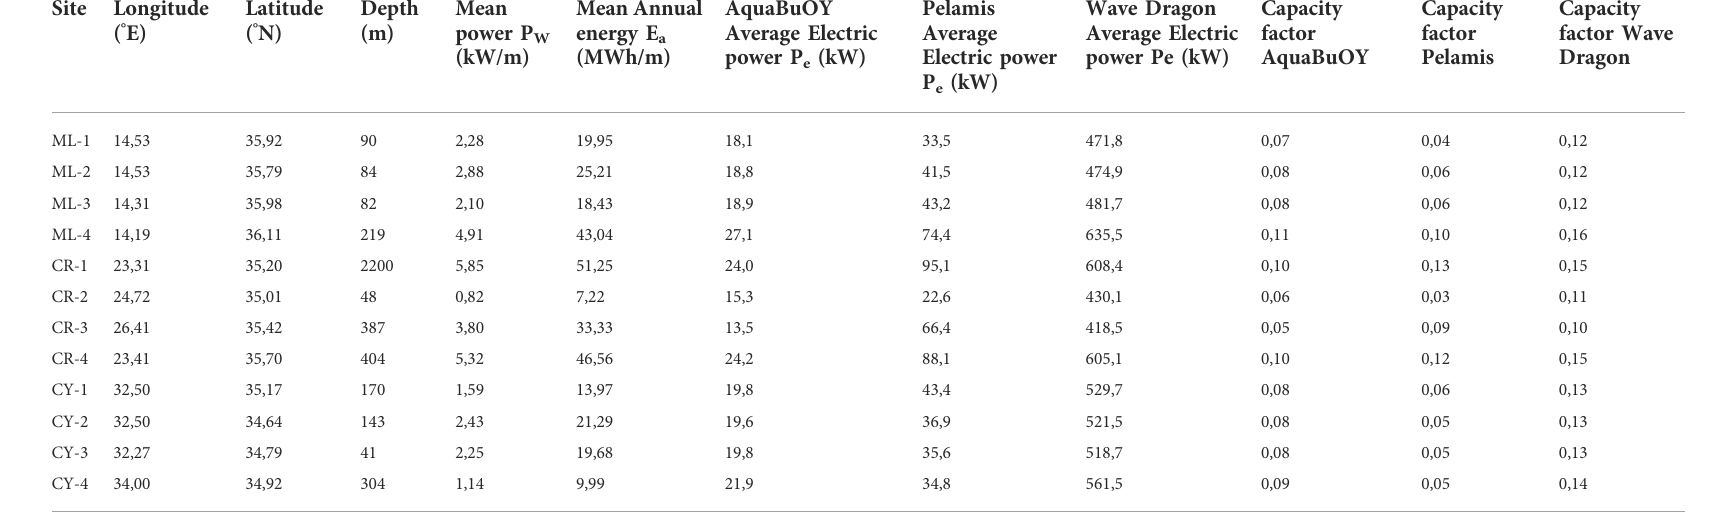
TABLE 1 Synthesis of the relevant parameters that characterize the locations considered in this study.